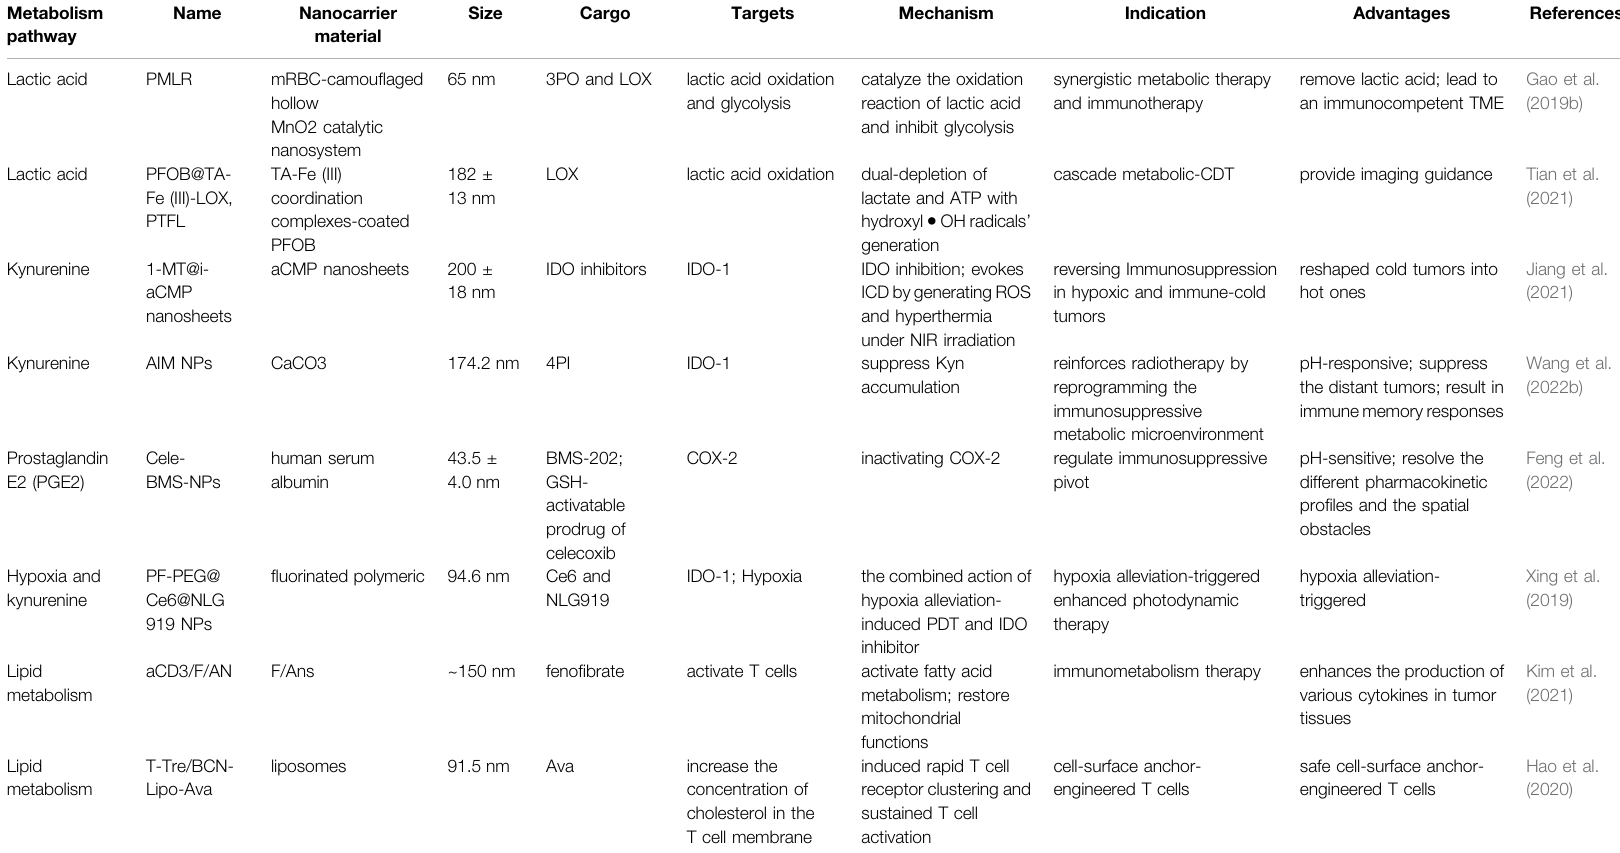
TABLE 2 | Representative nanoparticles targeting TME